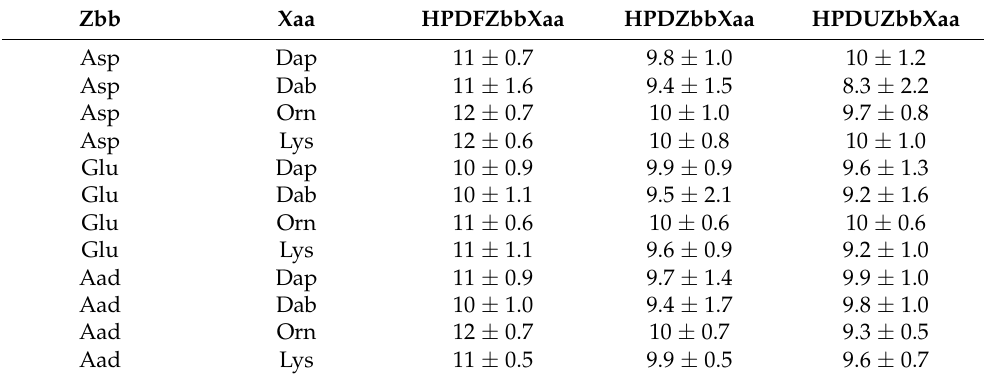
Table 2. The average 3 J NH α coupling constant values for the strand residues in the HPDFZbbXaa, HPDZbbXaa, and HPDUZbbXaa peptides 1